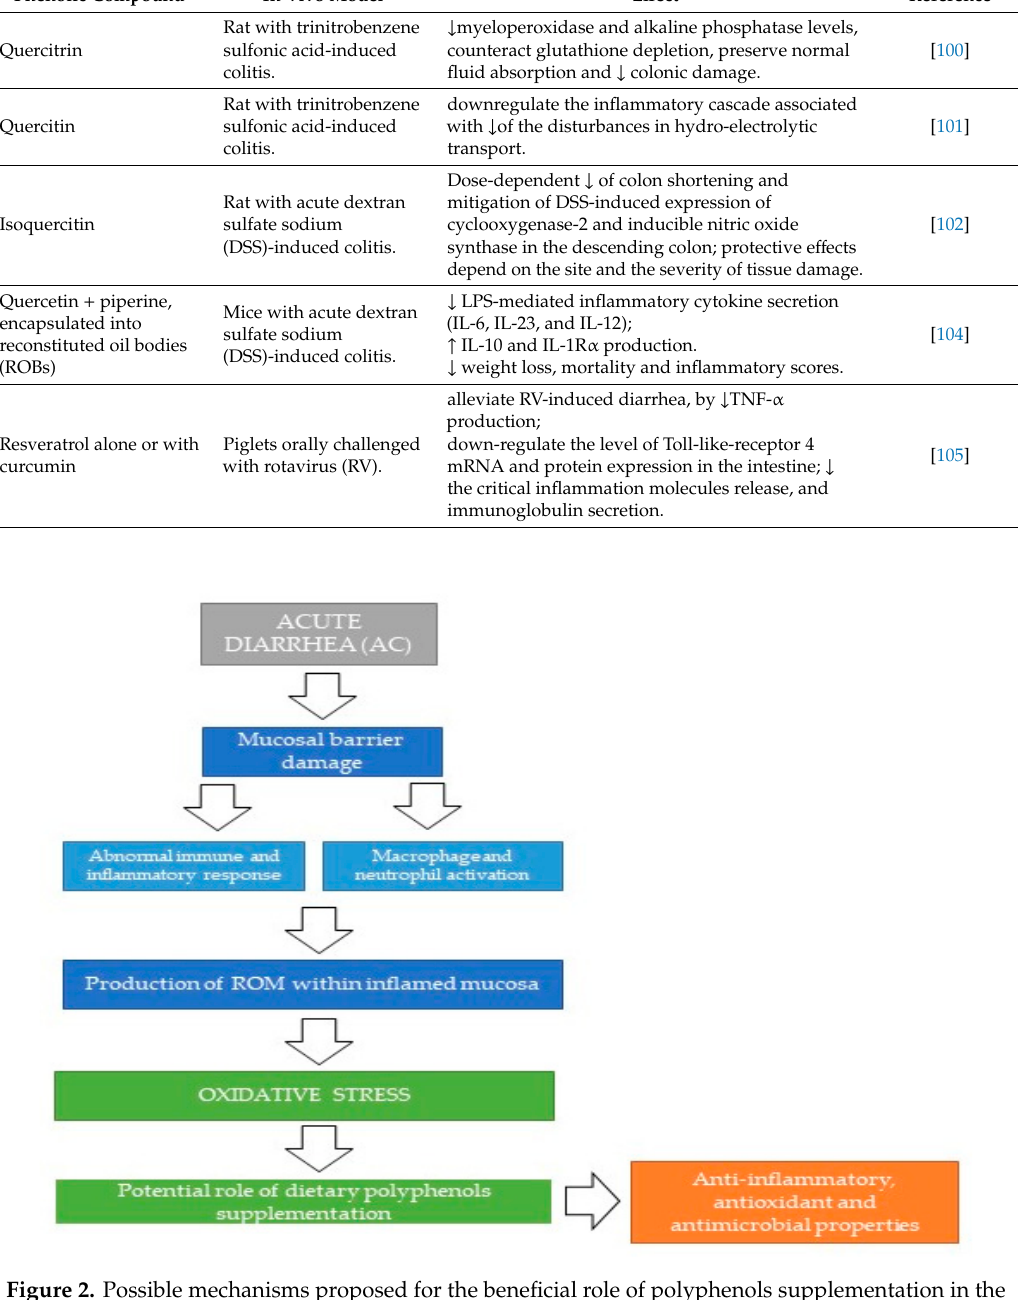
Figure 2. Possible mechanisms proposed for the beneficial role of polyphenols supplementation in the course of acute enteropathies. ROM: Reactive Oxygen Metabolites.